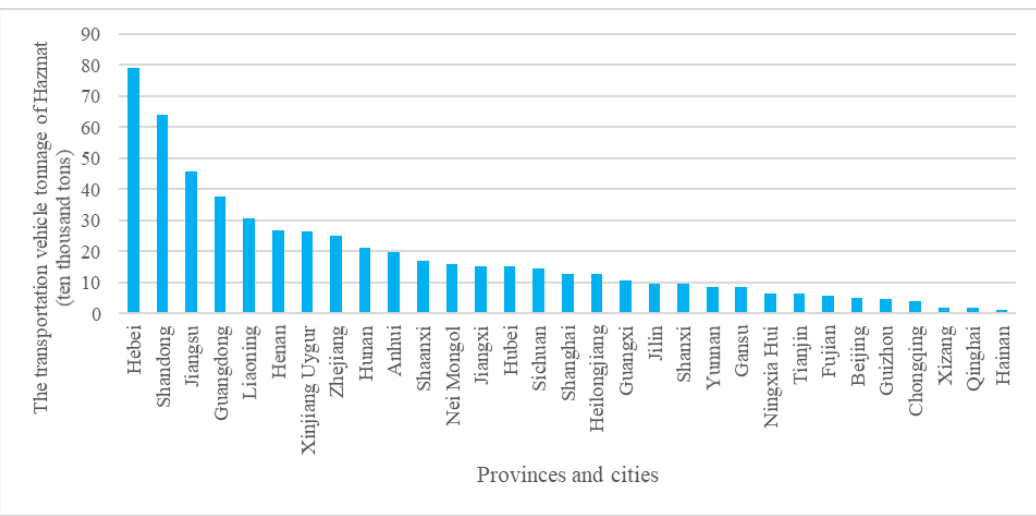
Figure 2. Status of Hazmat road transportation in different provinces at 2016.